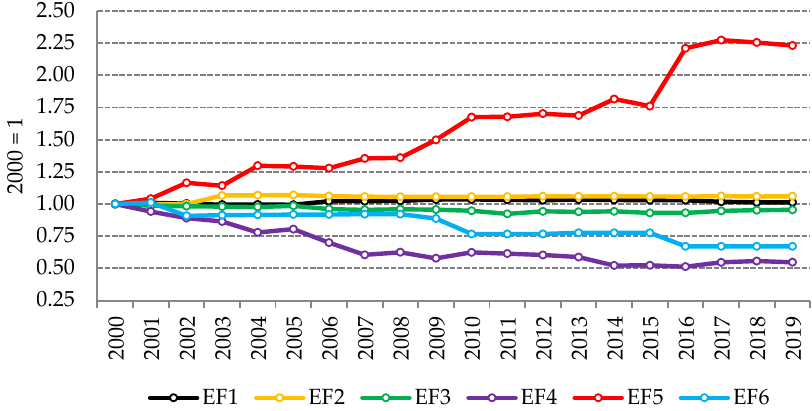
Figure 3. Pace of changes in factors of the decomposition model for CO 2 emissions from energy consumption in the Polish agricultural sector in 2000 – 2019 (2000 = 1).